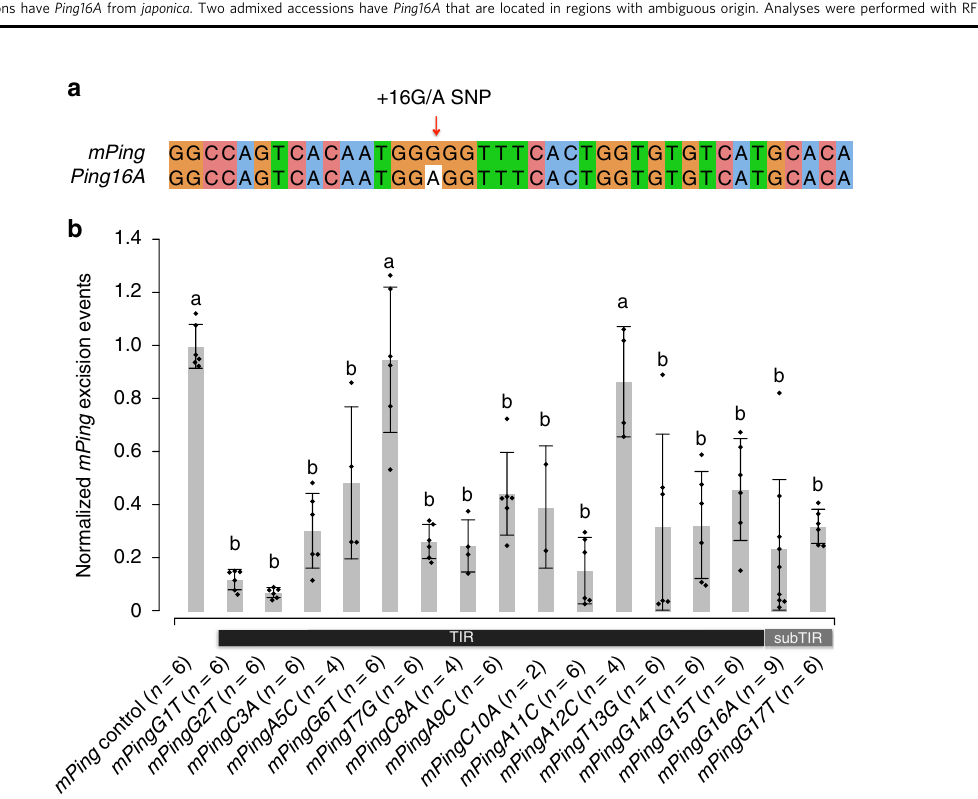
Fig. 3 Transposition frequency of mPing variants in the yeast assay. a Sequence alignment of mPing and Ping16A terminal sequence (1 – 40 bp). The SNP between mPing and Ping16A at position 16 ( + 16 G/A SNP) is indicated by the red arrow. b Transposition frequency of mPing variants with mutations at the 5 ʹ end in the yeast assay. X axis indicates mPing variants with mutations at 14 positions in the 5 ʹ TIR and two positions outside the TIR. For example, mPingG16A represents an mPing variant having a G-to-A mutation at position 16. A variant mPingC4A was not included because the lack of quali fi ed experiments. Y axis shows transposition frequency that was measured as mPing excision events per million cells and normalized to the control mPing . The error bars show standard deviation (s.d.) of 2-9 independent biological replicates. Letters (a and b) above the bars indicate signi fi cant differences of transposition frequency between mPing variants and control (adjusted P -value ≤ 0.05). The adjusted P- values are based on a one-way ANOVA ( P- value